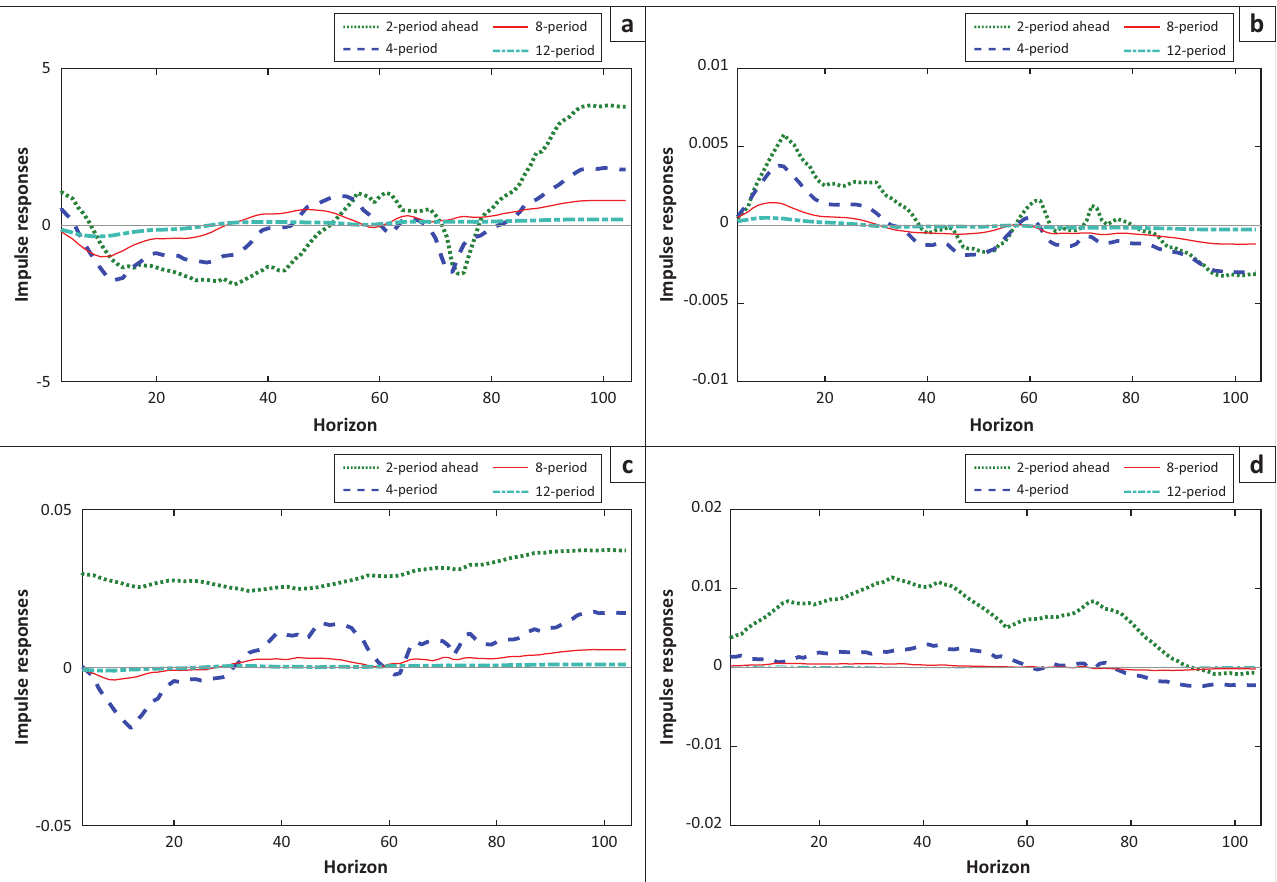
FIGURE 7: Impulse responses of selected macroeconomic variables to a positive economic policy uncertainty shock: (a) ε (d) ε ↑ → reer epu